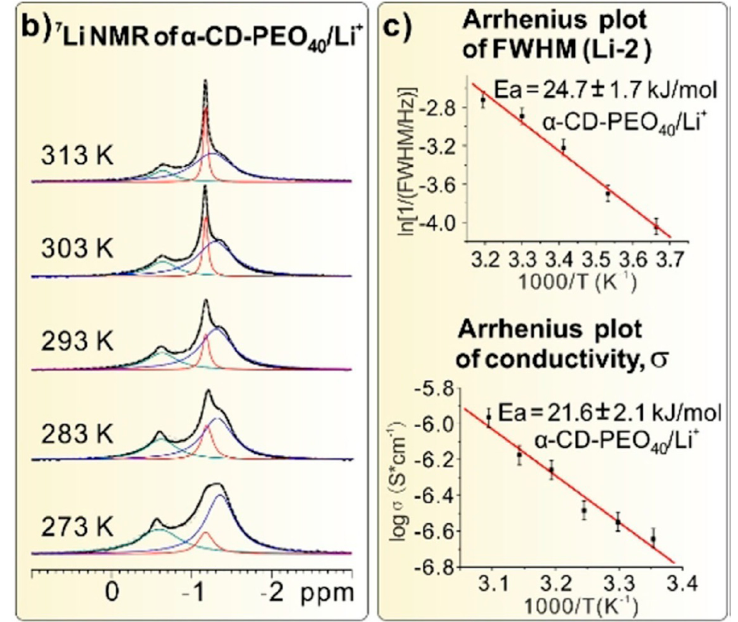
Figure 11. ( Left ) Temperature-dependent 7 Li NMR spectra of α -CD-PEO40/Li + from 273 K to 313 K. ( right ) Top: The Arrhenius plot of the line widths of Li-2 from the temperature-dependent 7 Li NMR; Bottom: The Arrhenius plot of the conductivities of α -CD-PEO40/Li + [87] © 2018 WILEY-VCH Verlag GmbH & Co. KGaA, Weinheim.